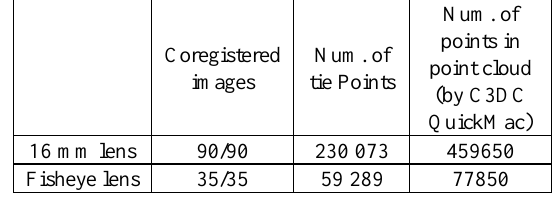
Table 4. Results of processing in MicMac.